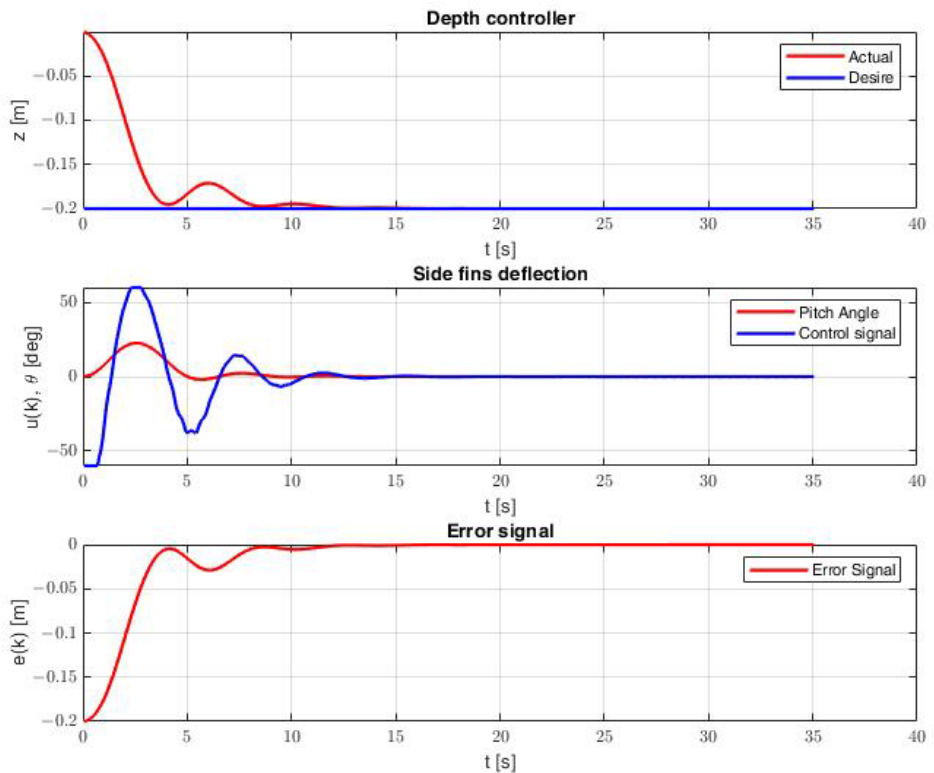
Figure 8. Changes of immersion and side fins deflection in time in response to desired depth: 0.2 [m] obtained for PID controller settings using GA method and fitness function no. 3 for small